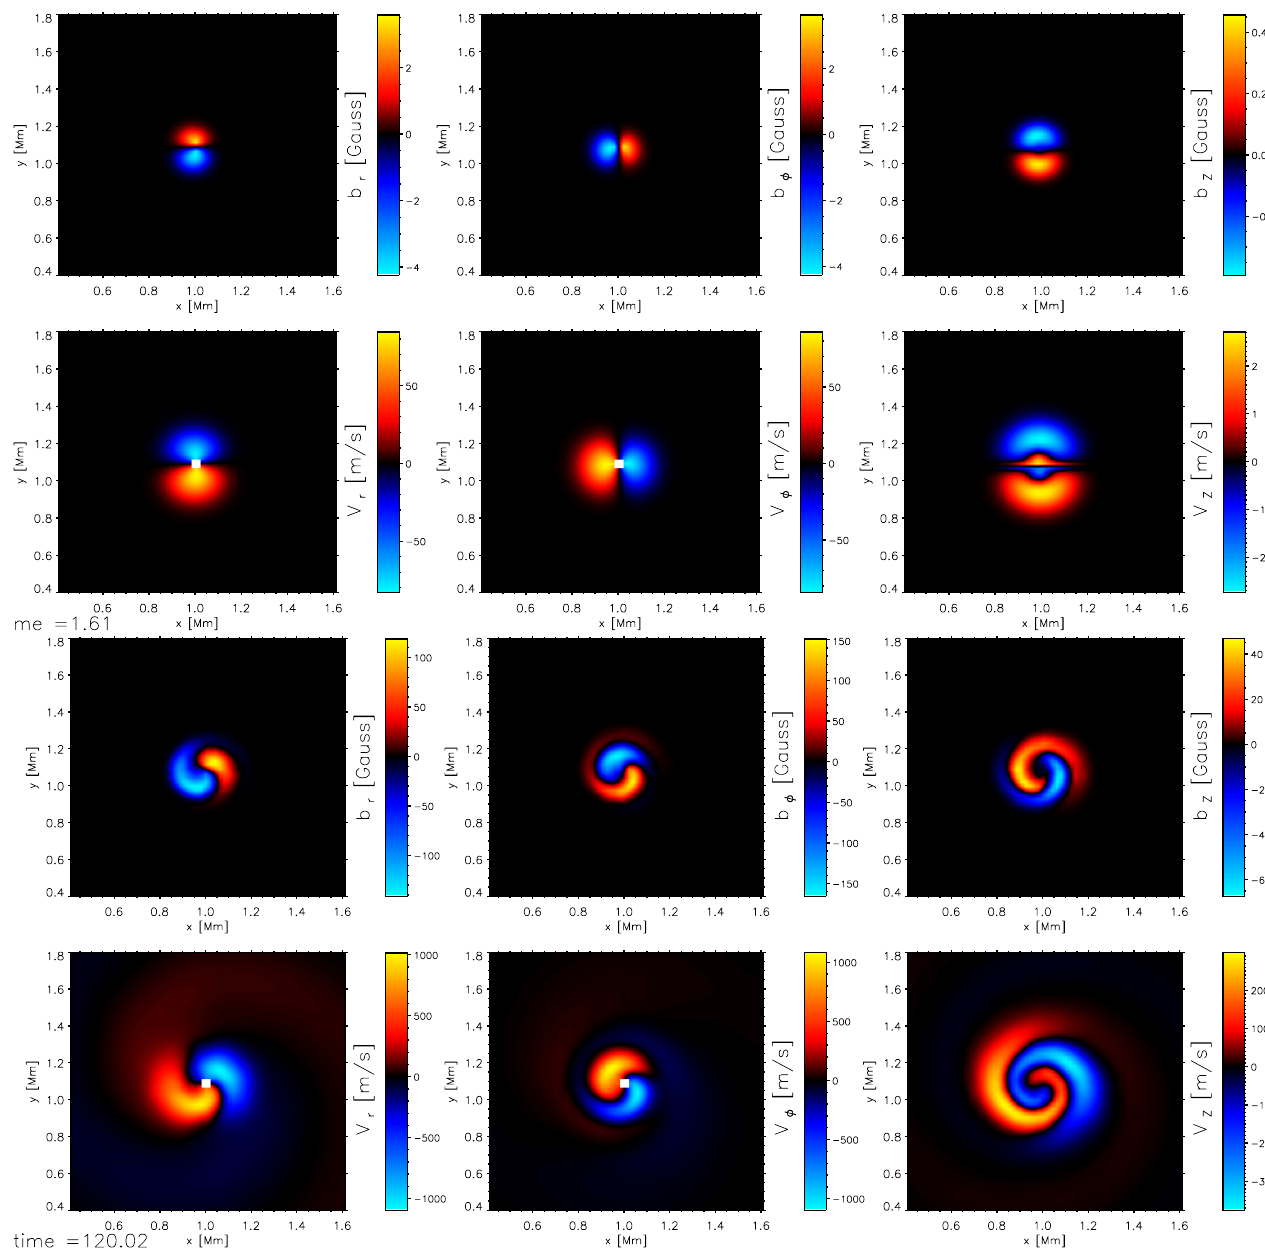
Fig. 2. Rendering of the magnetic field ( b r , b φ , b z ) and velocity ( V r , V φ , V z ) perturbation components generated by the vortex-type periodic driver (see Eq. 2) at the footpoint of the magnetic flux tube. Two different times are shown. The top and bottom sets of six horizontal slices at hight h = 0 . 12Mm correspond to simulation times t = 1 . 5s and t = 120 . 02s,